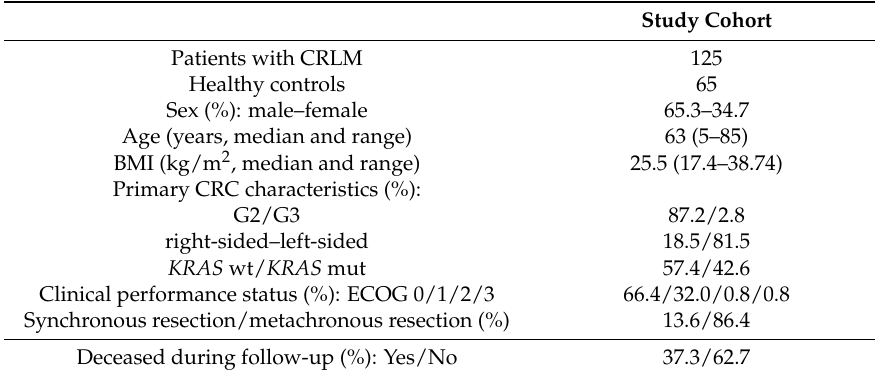
Table 1. Characteristics of study